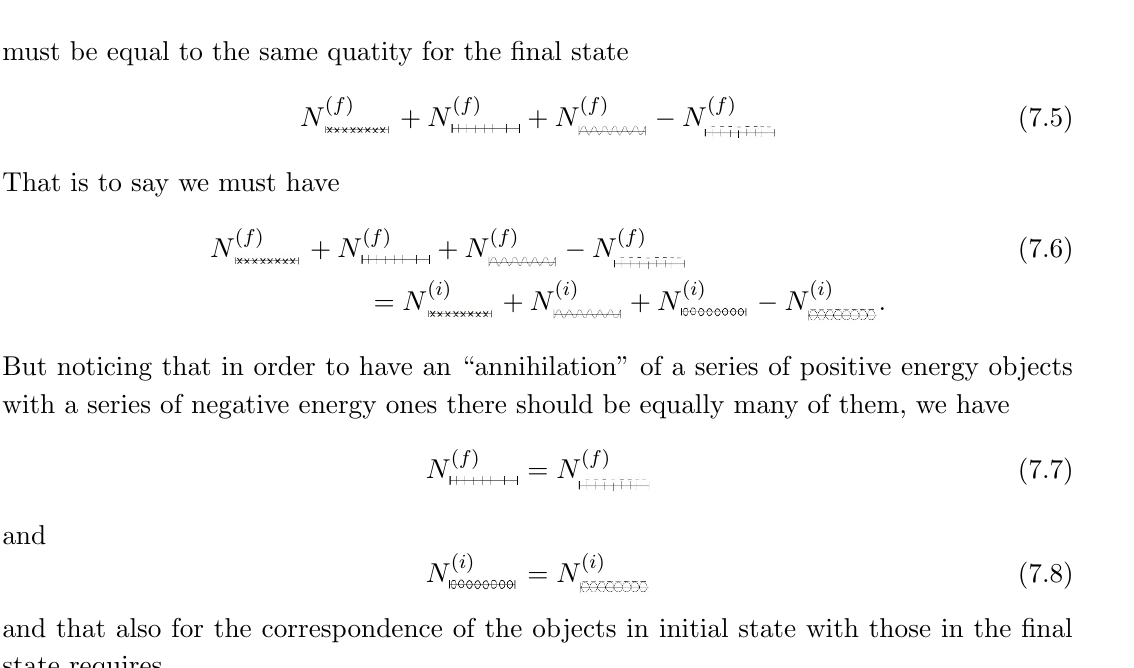
Figure 31 . The important part of the set of the cyclically ordered chain of objects that really exists on the (cid:12)gure depicted as (cid:12)gure